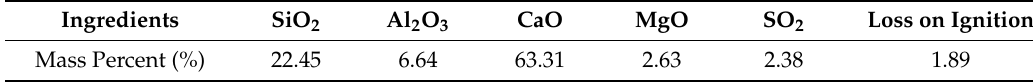
Table 1. Chemical composition of